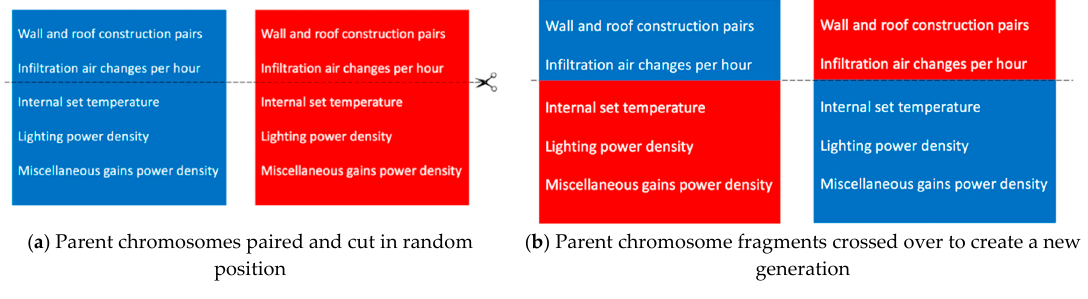
Figure 5. Calibration parameters in chromosome crossover.